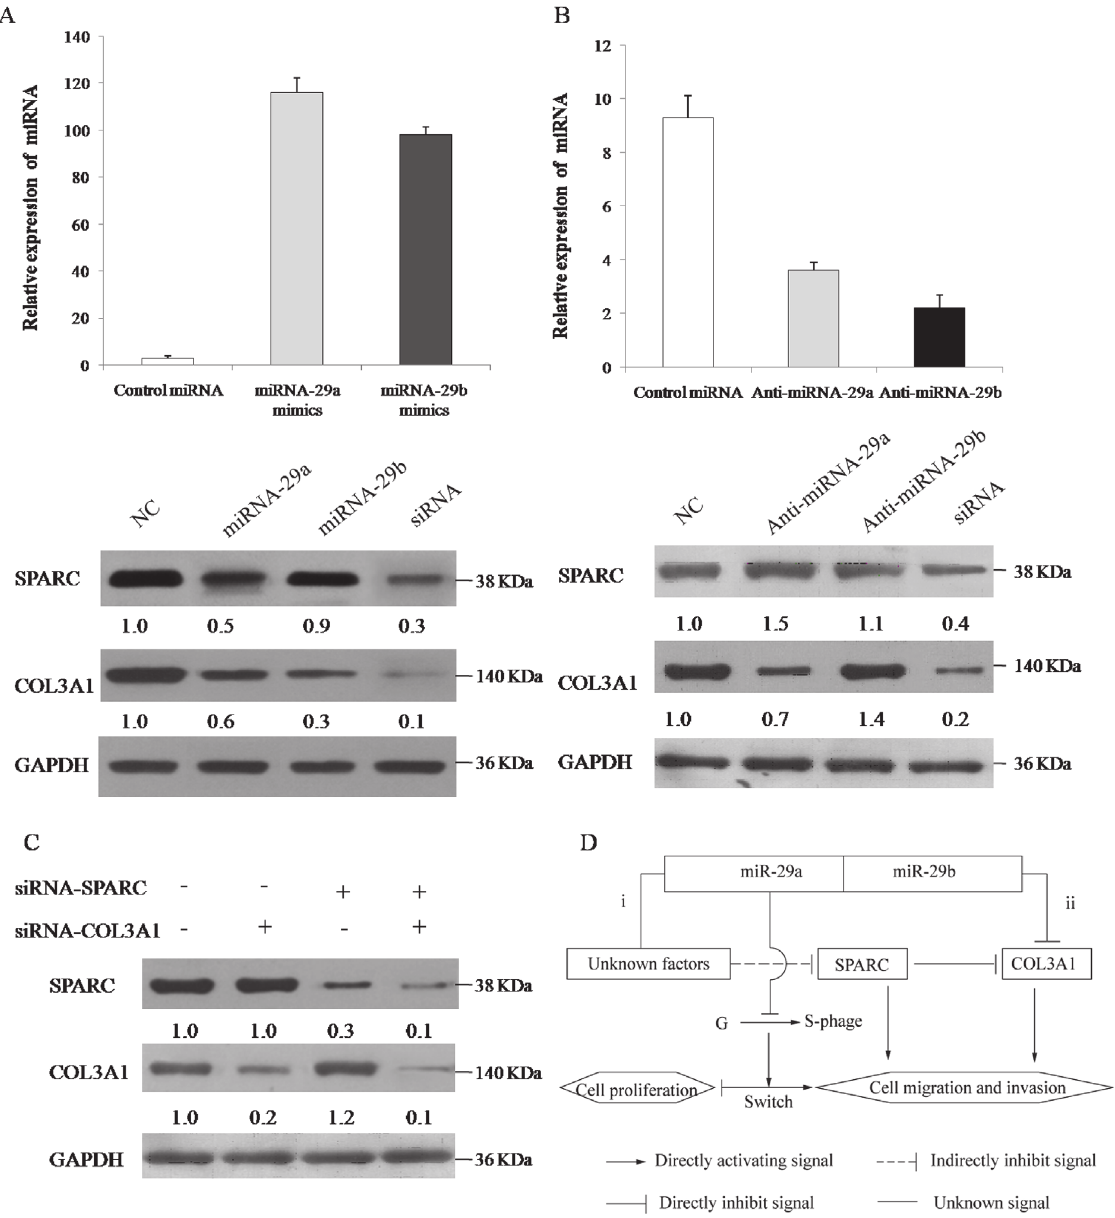
Fig 5. miR-29a/b target the SPARC/COL3A1 pathways in NPC cells. (A, B) S18 cells were transfected with 50 nmol of mimics-NC (control miRNA), mimics-miR-29a/b, anti-scramble (control anti-miRNA) and anti-miR-29a/b. The levels of miR-29a and miR-29b were assessed by qRT-PCR. Cell lysates were prepared for Western blotting with antibodies against SPARC and COL3A1, and GAPDH expression served as a loading control. Western blot figures are representative of at least three independent experiments. The value under each sample indicates the fold change of SPARC and COL3A1 protein levels relative to that of the control. (C) Western blot analysis of the expression level of SPARC and COL3A1 in NPC cells following treatment with vehicle, siRNA- SPARC and siRNA-COL3A1 for 24 h. The value under each sample indicates the fold changes of SPARC and COL3A1 protein levels relative to that of the control. Three independent experiments performed in triplicate. (D) A schematic model shows the function of miR-29a and miR-29b in NPC cell proliferation, migration and cell invasion. In response to miR-29a/b stimuli, the G1/S transition arrest triggers both a classical proliferative inhibition and an adapted metabolic switch. SPARC and COL3A1 protein levels inversely correlate with miR-29a and miR-29b expression in NPC cells, respectively. (i) The indirect effect of miR-29a to increase SPARC expression may be mediated by its unknown targets that affect cell survival, and subsequently SPARC could down- regulate the expression of COL3A1. (ii) COL3A1 is a direct target of miR-29b and affects the expression of the various ECM proteins, resulting in derepression of NPC cell migration and